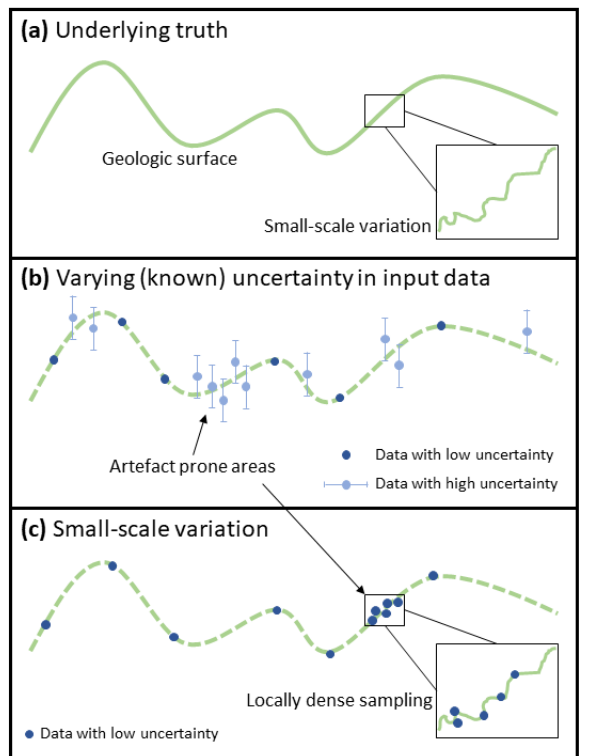
Figure 2. Modeling problems tackled by informed local smoothing: ( a ) Underlying truth with geologic surface. ( b ) Input data with varying quantified uncertainties. ( c ) Locally dense sampling of small-scale variation below desired model